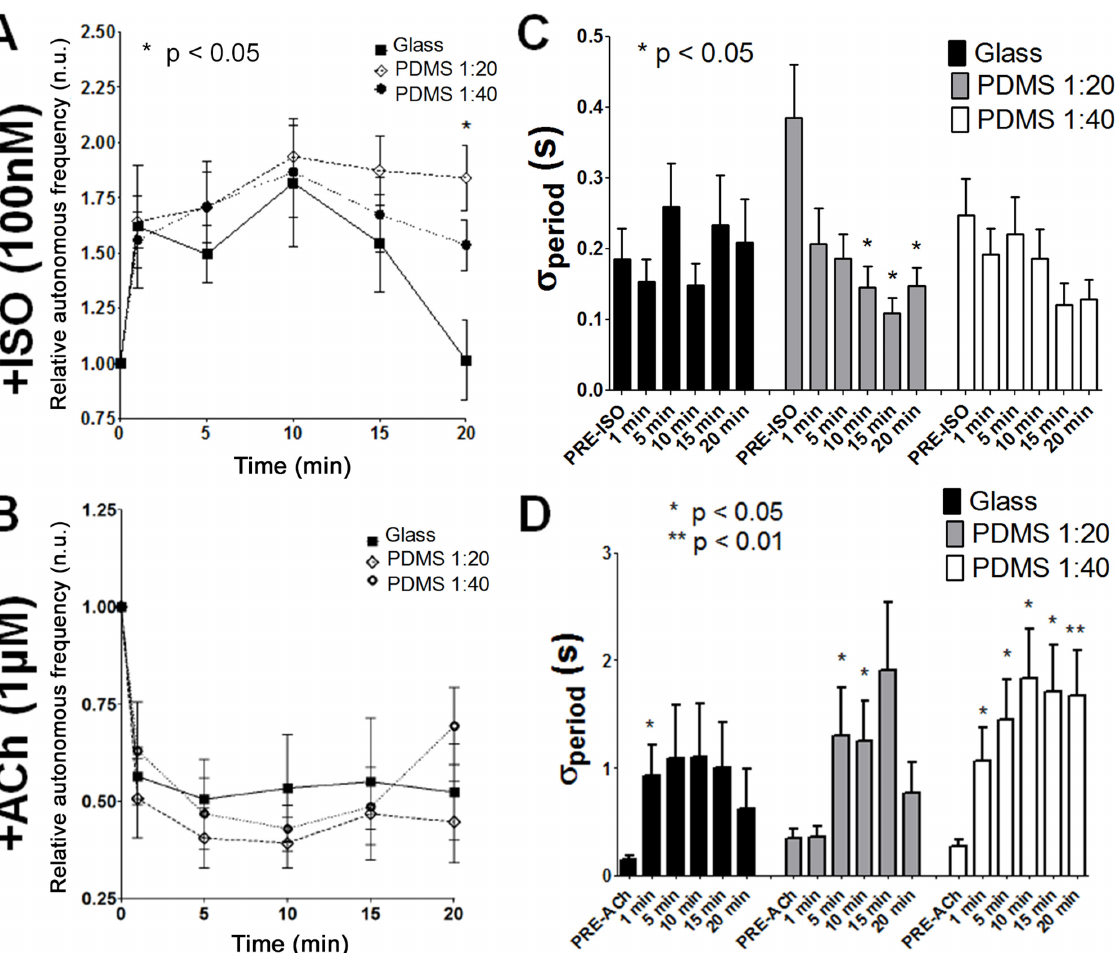
Fig 5. Effects of parasympathetic and sympathetic stimulation on the rate of spontaneous activity. Relative spontaneous frequency was obtained by videomicroscopy and calculated by taking spontaneous frequency recorded at t = 1, 5, 10, 15, and 20 minute(s) and by dividing that value by the spontaneous frequency prior to the addition of the drug (pre-drug at t = 0). A. Sympathetic stimulation by addition of 100 nM of ISO. The rates of contraction at t = 1 minute after the addition of ISO were 1.62 ± 0.28 Hz (glass), 1.64 ± 0.12 Hz (PDMS 1:20), and 1.56 ± 0.13 Hz (PDMS 1:40); consequently, no significant differences were observed at t = 1 minute between the groups (p = 0.53). However, the rates of contraction at t = 20 minutes after the addition of ISO were 1.14 ± 0.15 Hz (glass), 1.84 ± 0.15 Hz (PDMS 1:20), and 1.54 ± 0.11 Hz (PDMS 1:40). Statistical analysis showed significant differences at t = 20 minutes between the groups (p < 0.01). B. Effects of parasympathetic stimulation by addition of 1 μ M of ACh. The rates of contraction at t = 1 minute after the addition of ACh were 0.56 ± 0.07 Hz (glass), 0.51 ± 0.10 Hz (PDMS 1:20), and 0.63 ± 0.12 Hz (PDMS 1:40); consequently, no significant differences were observed at t = 1 minute between the groups (p = 0.700). The rates of contraction at t = 20 minutes after the addition of ACh were 0.52 ± 0.12 Hz (glass), 0.45 ± 0.11 Hz (PDMS 1:20), and 0.69 ± 0.10 Hz (PDMS 1:40); no significant differences were observed at t = 20 minutes between the groups (p = 0.33). C. No changes in σ period were observed with time for cardiomyocytes cultivated on glass after the addition of ISO. The period for cardiomyocytes cultivated on PDMS 1:20 was decreased significantly 10, 15, and 20 minutes after the addition of ISO (p < 0.05, Mann-Whitney comparison test). There was a tendency towards a decreased σ period for cardiomyocytes cultivated on PDMS 1:40 in the presence of ISO. D. A significant increase in σ period at t = 1 minute (p < 0.05, Mann- Whitney comparison test) was observed for cardiomyocytes cultivated on glass after the addition of ACh. No significant change was observed for the remaining measurements (t = 5, 10, 15, and 20 minutes). The σ period for cardiomyocytes cultivated on PDMS 1:20 only increased significantly at t = 10 and 15 minutes after the addition of ISO (p < 0.05, Mann-Whitney comparison test). A significant increase in σ period was observed for PDMS 1:40 at t = 1, 5, 10, 15, and 20 minutes (p < 0.05, Mann-Whitney comparison